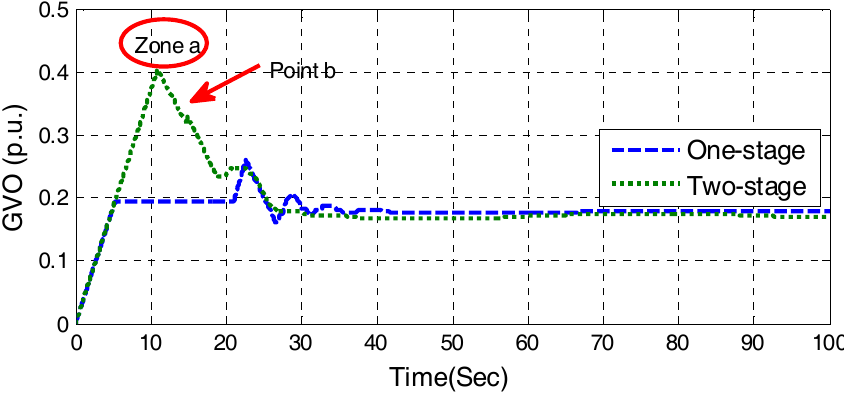
Figure 18. Change process of guide vane opening of traditional start-up strategies with Scheme B. Table 11. Performance indices of traditional start-up strategy of PSU in optimization Scheme B.